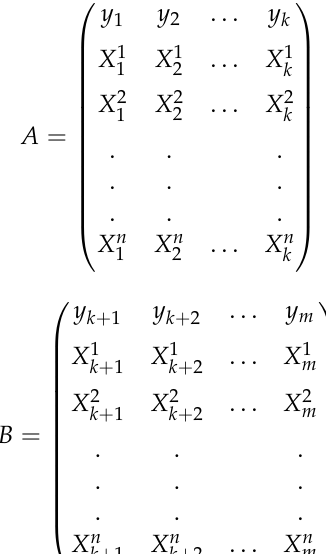
3. Train the non-linear algorithm with the training dataset ( ϕ ( A ) ). 4. Estimate classification forecasts